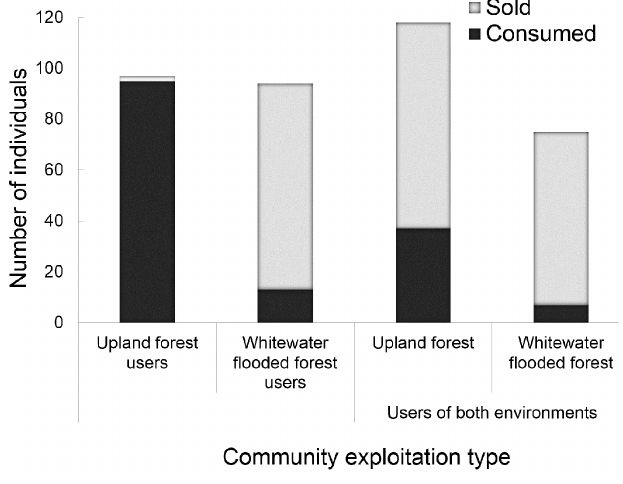
Fig. 4 . Patterns of consumption and trade of yellow-footed tortoises ( Chelonoidis denticulata ) by community type according to the environment